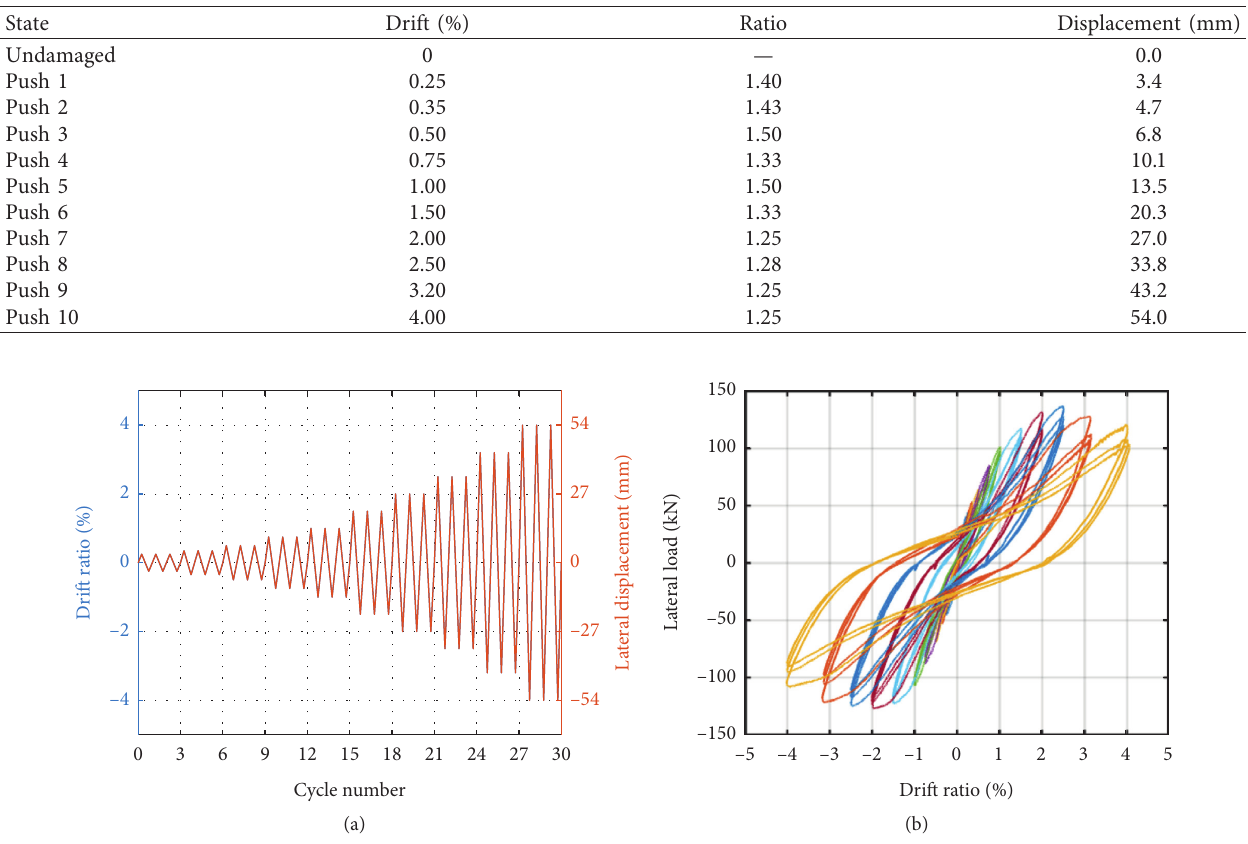
Figure 5: (a) Cyclic loading protocol and (b) lateral load vs. drift curves.